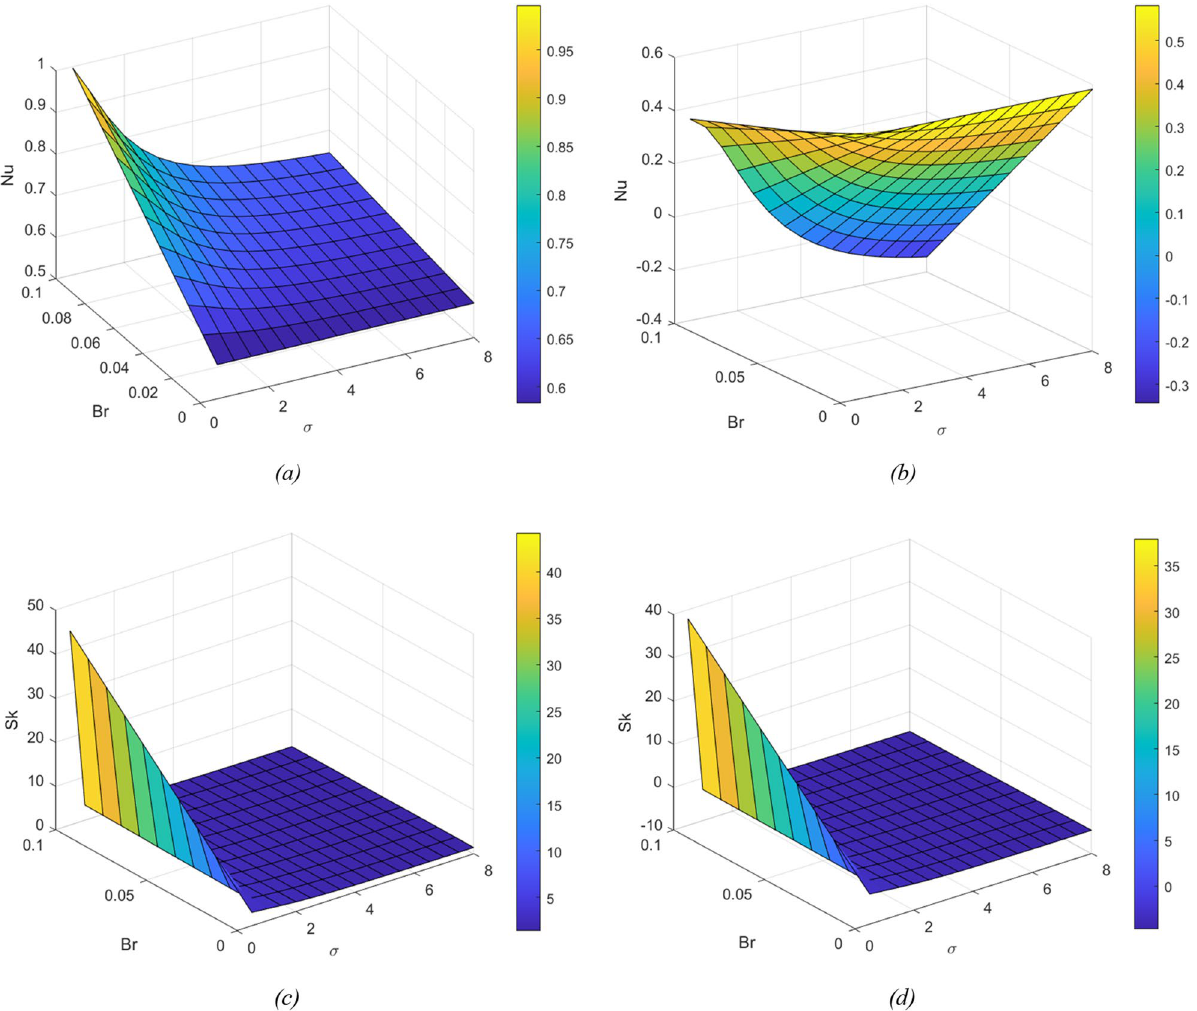
Figure 9. Nusselt graphs for change in Br and σ ( a ) at the left plate (y = − 1) ( b ) at the right plate (y =). Skin friction for change in Br and σ ( c ) at the left plate (y = − 1) ( d ) at the right plate (y = 1).